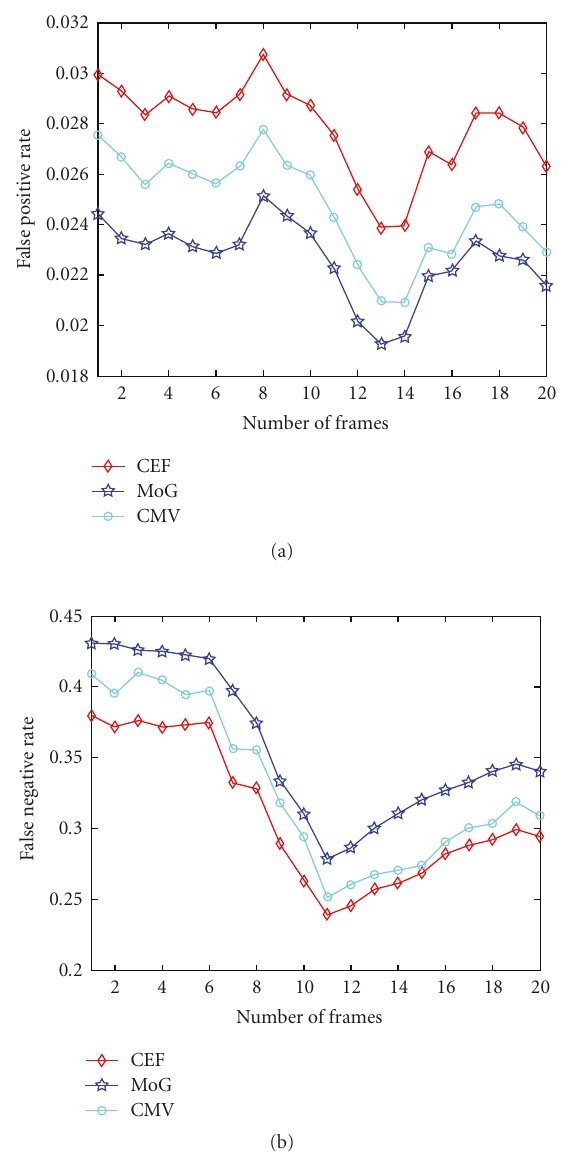
Figure 12: (a) false positive and (b) false negative error rates versus number of frames for Dataset